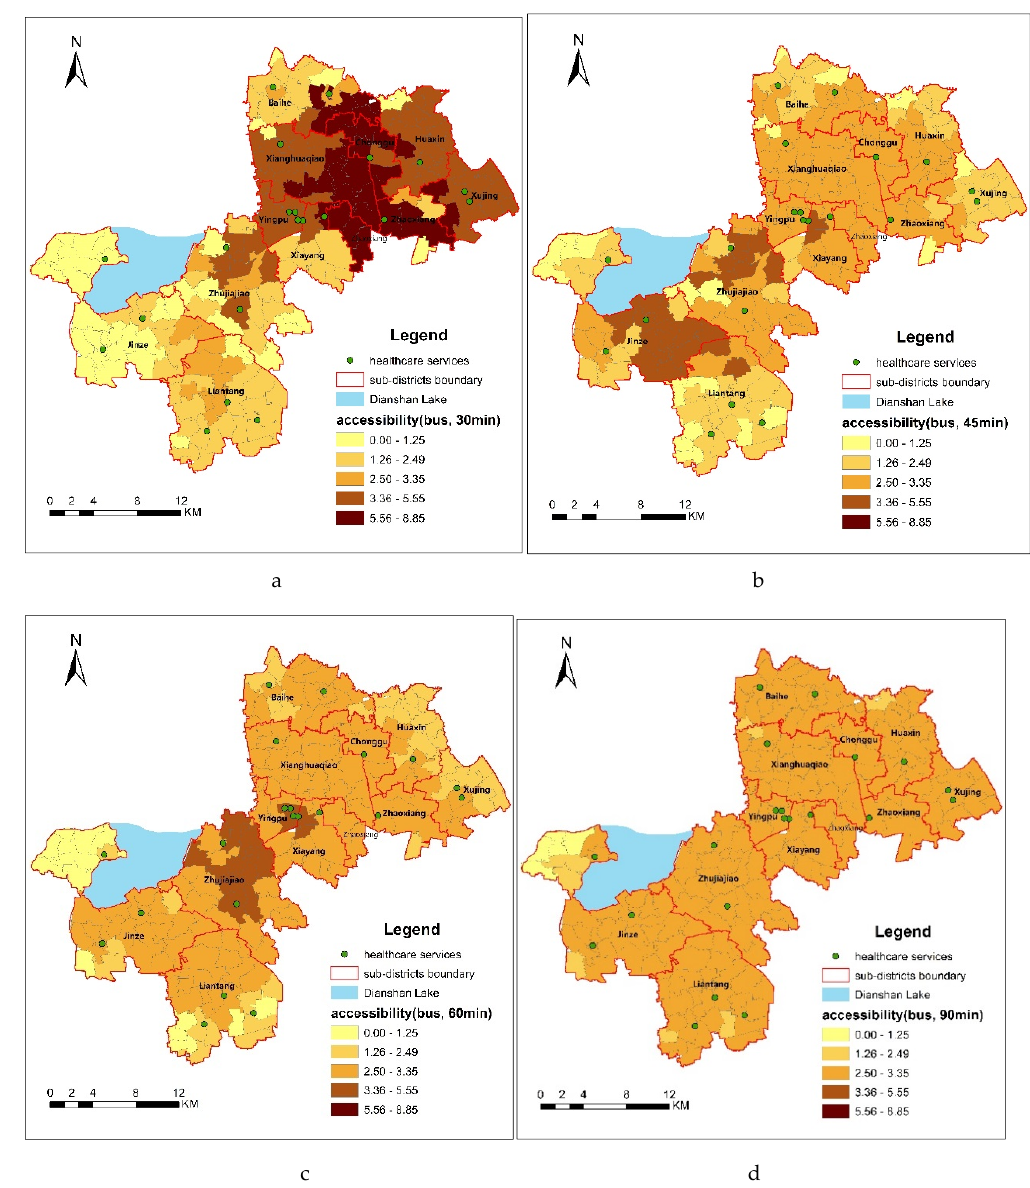
Figure 5. Spatial accessibility by bus under thresholds of ( a ) 30, ( b ) 45, ( c ) 60 and ( d ) 90 min.